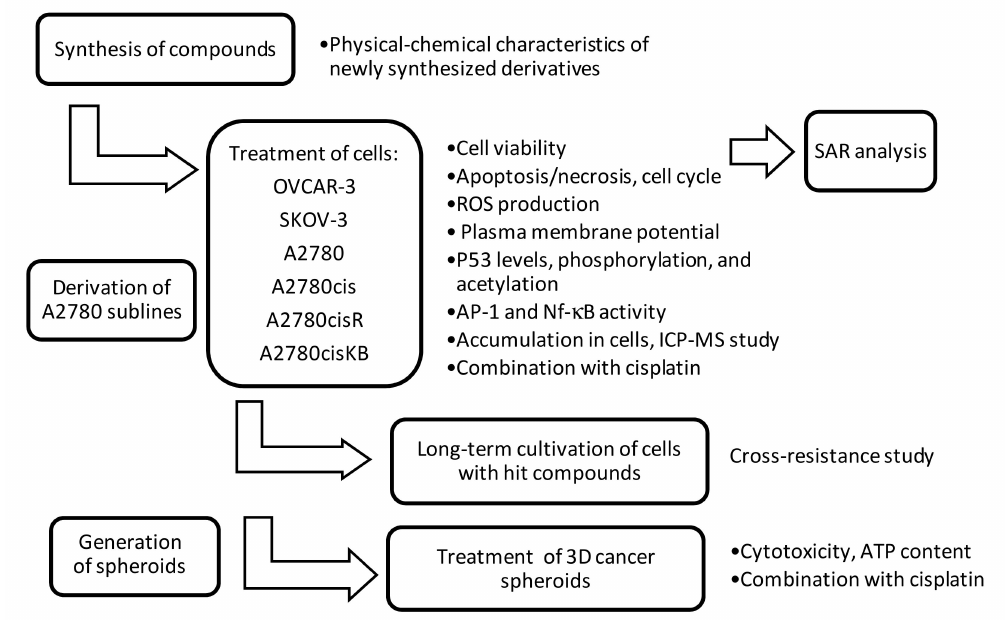
Figure 1. Principle of the current study. SAR—structure-activity relationship; ROS—reactive oxygen species; p53—tumor protein p53; AP-1—activator protein 1, transcription factor; Nf- κ B—nuclear factor kappa-light-chain-enhancer; ICP-MS— inductively coupled plasma mass spectrometry; ATP—adenosine triphosphates. Table 1. Comparison of platinum sensitivity of six ovarian carcinoma cell lines (IC 50 , mean ± SEM). Similarity